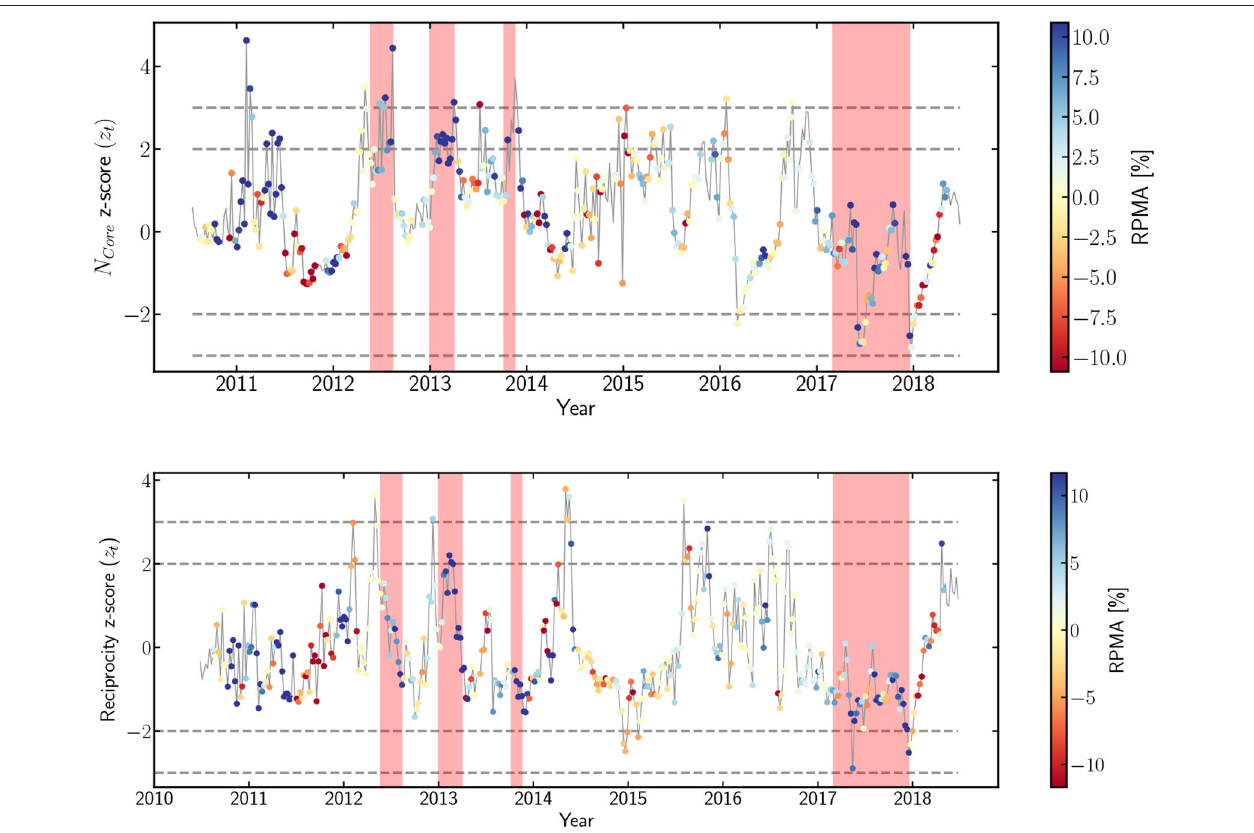
FIGURE 4 | Evolution of the temporal z -score for the number of core nodes (top panel) and the reciprocity (bottom panel) for the BUN weekly representation. Shaded areas indicate so-called bubbles , i.e., periods of price increase according to Wheatley et al. [36]. Additionally, each dot representing an observation is colored according to the value of the ratio between the current price and its moving average (RPMA) indicator. Overall, the two trends show some similarities, with peaks clearly visible in correspondence to so-called bubbles , identified by the shaded areas (see also Wheatley et al. [36]). Interestingly, these quantities are also significant in a statistical sense, as the temporal z -scores reach values of z ( t ) ≥